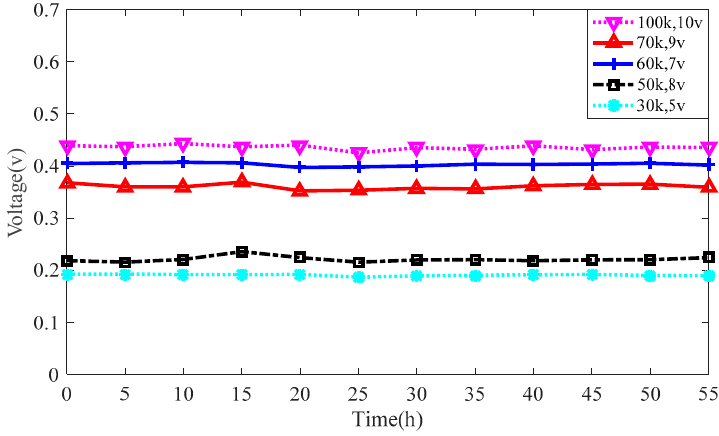
Figure 6. Relationship diagram of time and voltage.